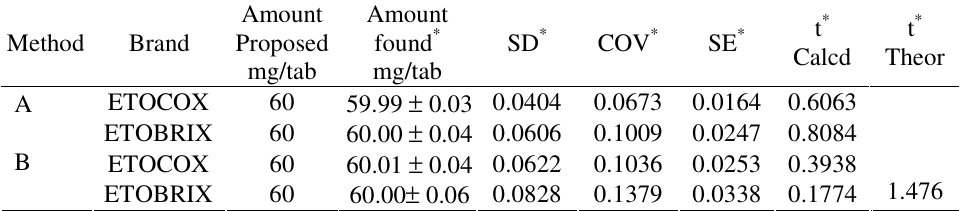
Table 3 . Statistical analysis of commercial formulations.